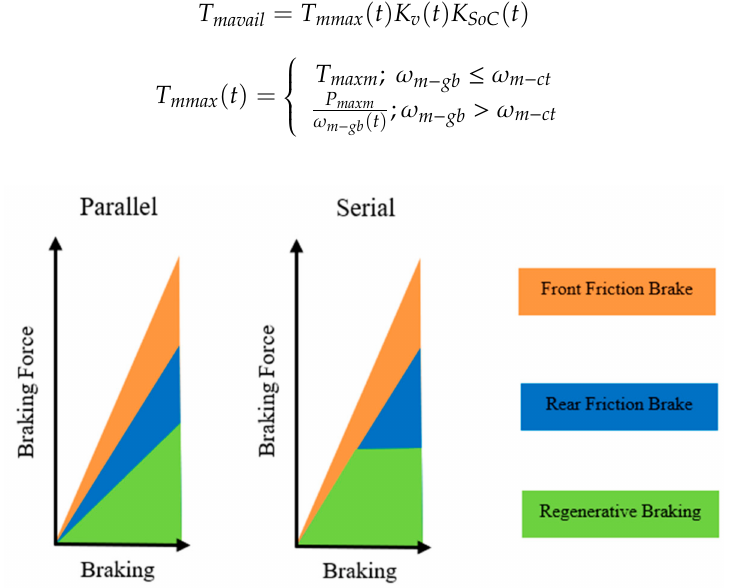
Figure 6. Schematic of the braking force distribution of serial and parallel configuration for a rear-wheeled vehicle